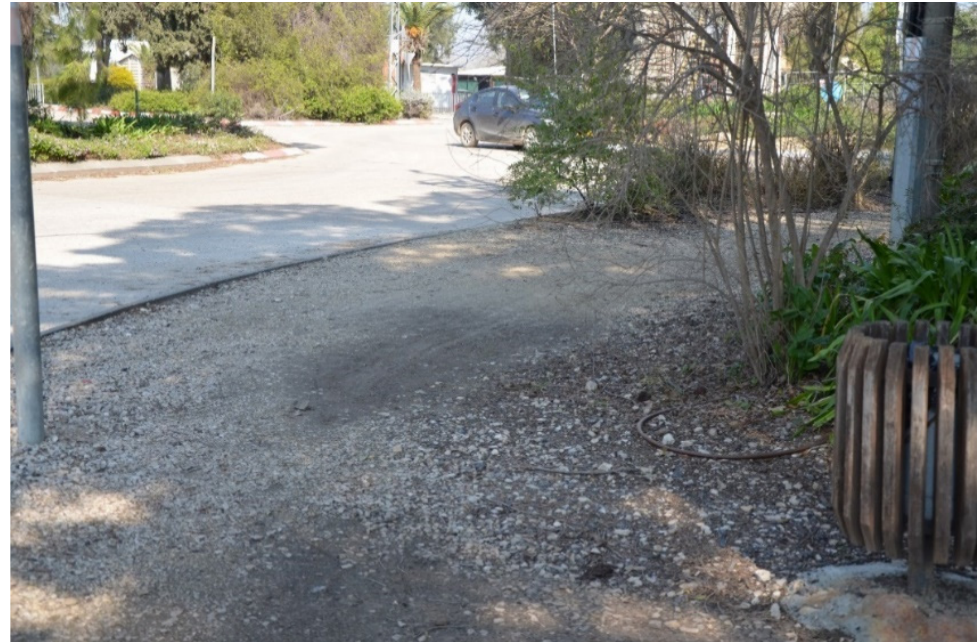
Figure 16. Missing sidewalk in Nahalal. Photo by the authors.